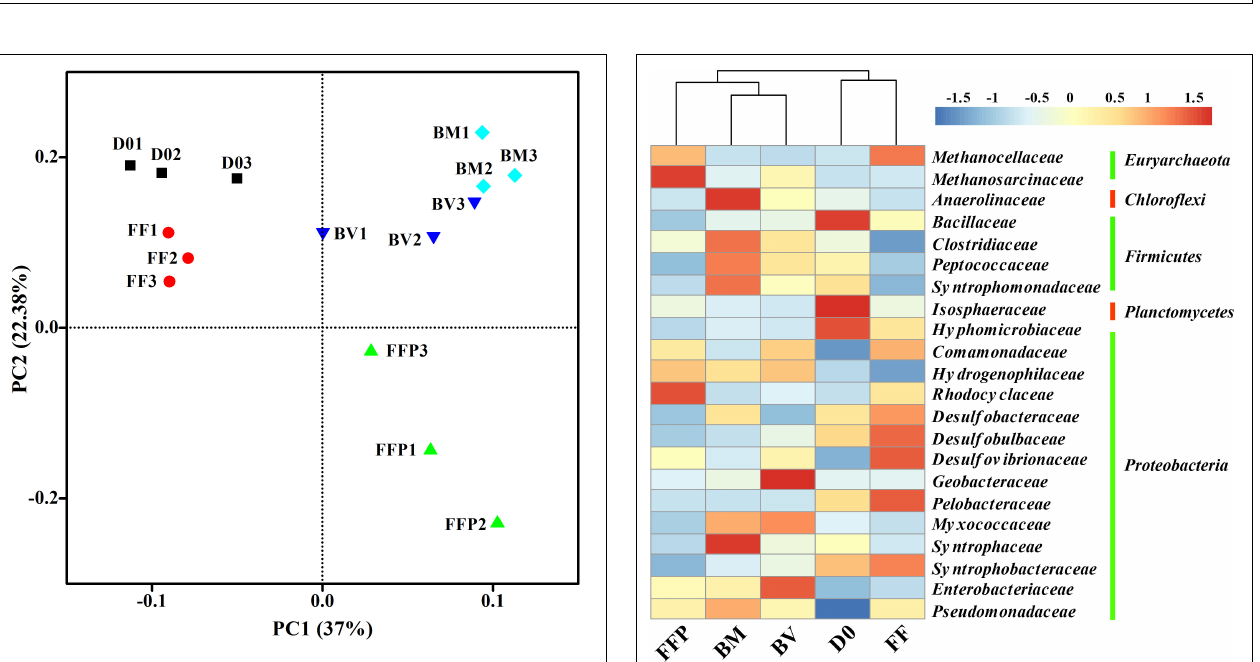
FIGURE 4 | Propionate degradation and the appearance and disappearance of acetate in different treatments: (A) ferrihydrite-free cultures, (B) ferrihydrite-free + P cultures, (C) biogenic-magnetite cultures, and (D) biogenic-vivianite cultures (the arrows denote the addition of propionate).